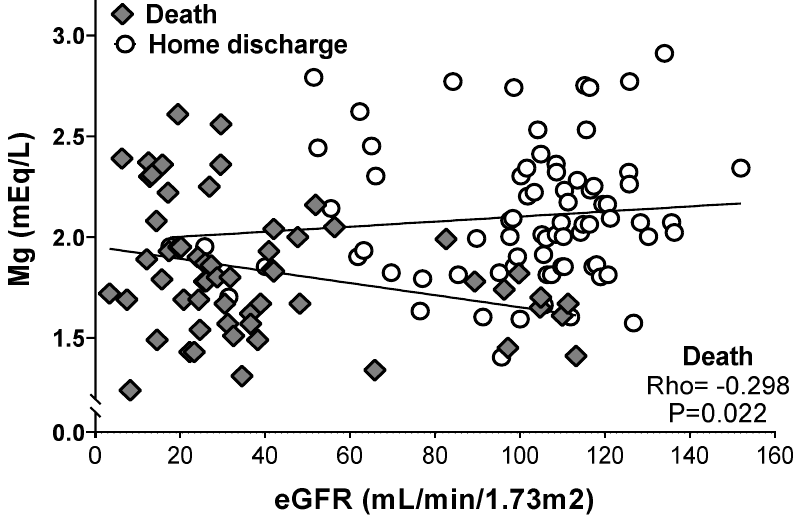
Figure 2. Magnesium levels correlate with estimated glomerular filtration rate (eGFR) in obese COVID-19 death patients versus obese COVID-19 home discharge patients. The association between parameters was determined by Spearman’s correlation coefficient. p < 0.05 was considered significant.